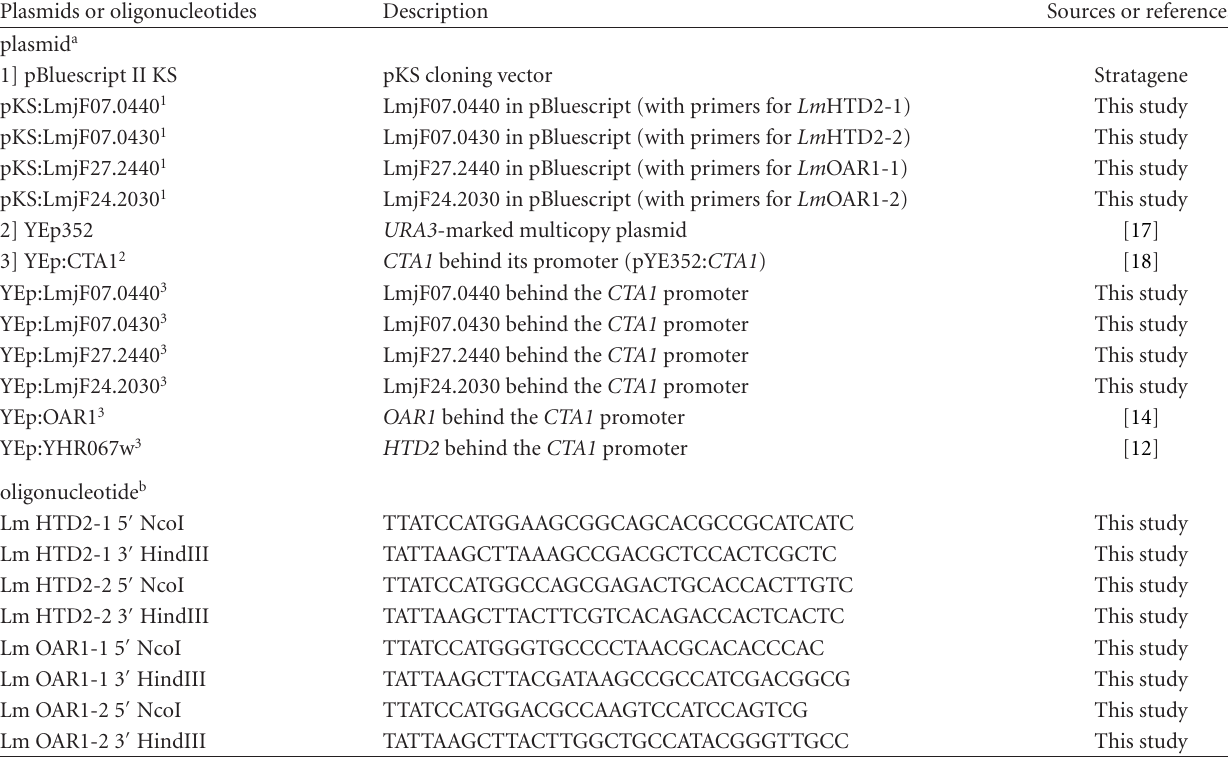
Table 1: Plasmids and oligonucleotides